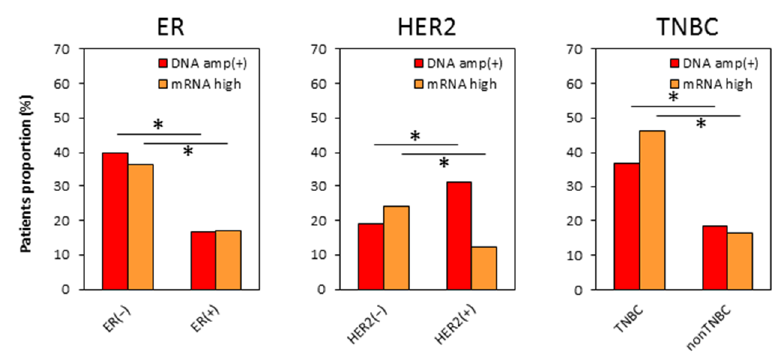
Figure 3. The patient distribution of the MYC DNA amplification and mRNA high expression by each subtype in TCGA breast cancer patients. MYC DNA amplified tumors (DNA amp( + ) as red column) and MYC mRNA high expression tumors (mRNA high as orange column).